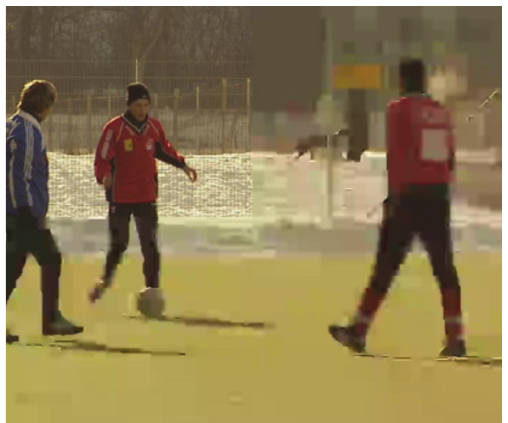
Figure 10: The “SOCCER” video sequence (SD-resolution, 25 fps), which contains the ROI region in the upper-left corner.